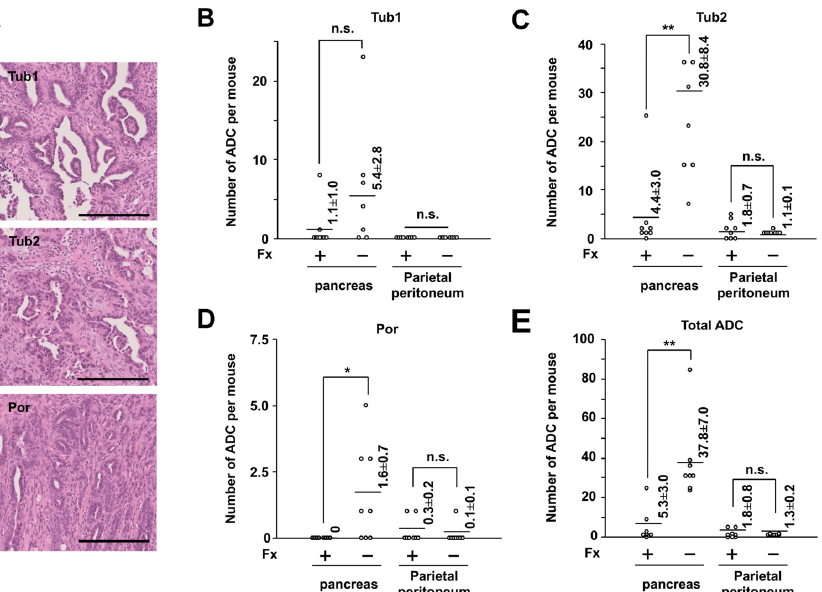
Figure 4. Effect of pancreatic cancer chemoprevention in pancreatic cancer model mice by fucoxanthin (Fx). ( A ) Representative histopathology of pancreatic adenocarcinoma (ADC). Bar, 200 µ m. Tub1, well differentiated tubular ADC. Tub2, moderately differentiated tubular ADC. Por, poorly differentiated tubular ADC. The number of ( B ) Tub 1, ( C ) Tub 2, ( D ) Por, and ( E ) total ADCs in pancreatic and parietal peritoneum tissues. Flat bars, Mean ± SE ( n = 8). * p < 0.05 and ** p < 0.01. n.s., no